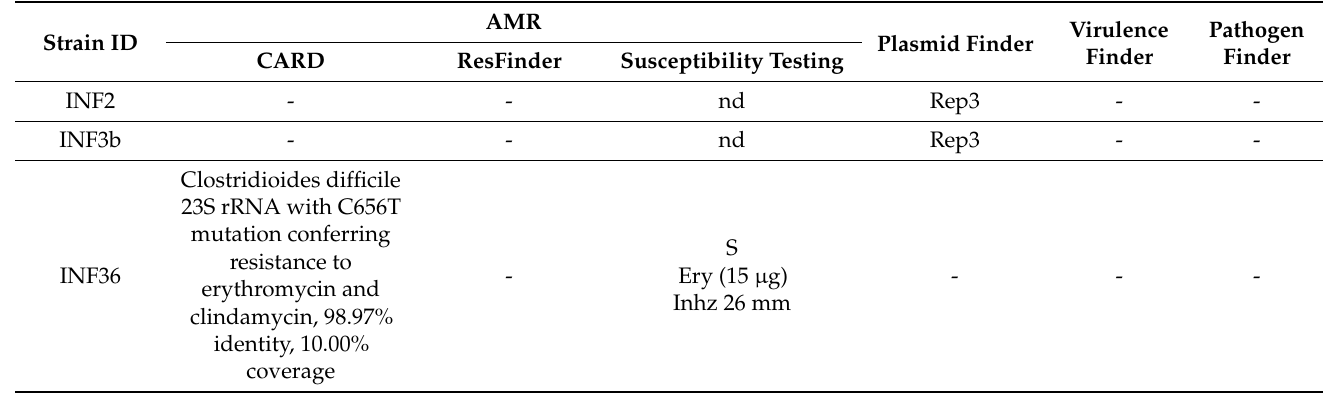
Table 3. AMR targets, virulence genes, plasmids, pathogenicity, (S) susceptible, (Ery) erythromycin, (Amp) ampicillin, (Pen) penicillin, (Inhz) inhibition zone, (-) negative, and (nd) not done. Strain